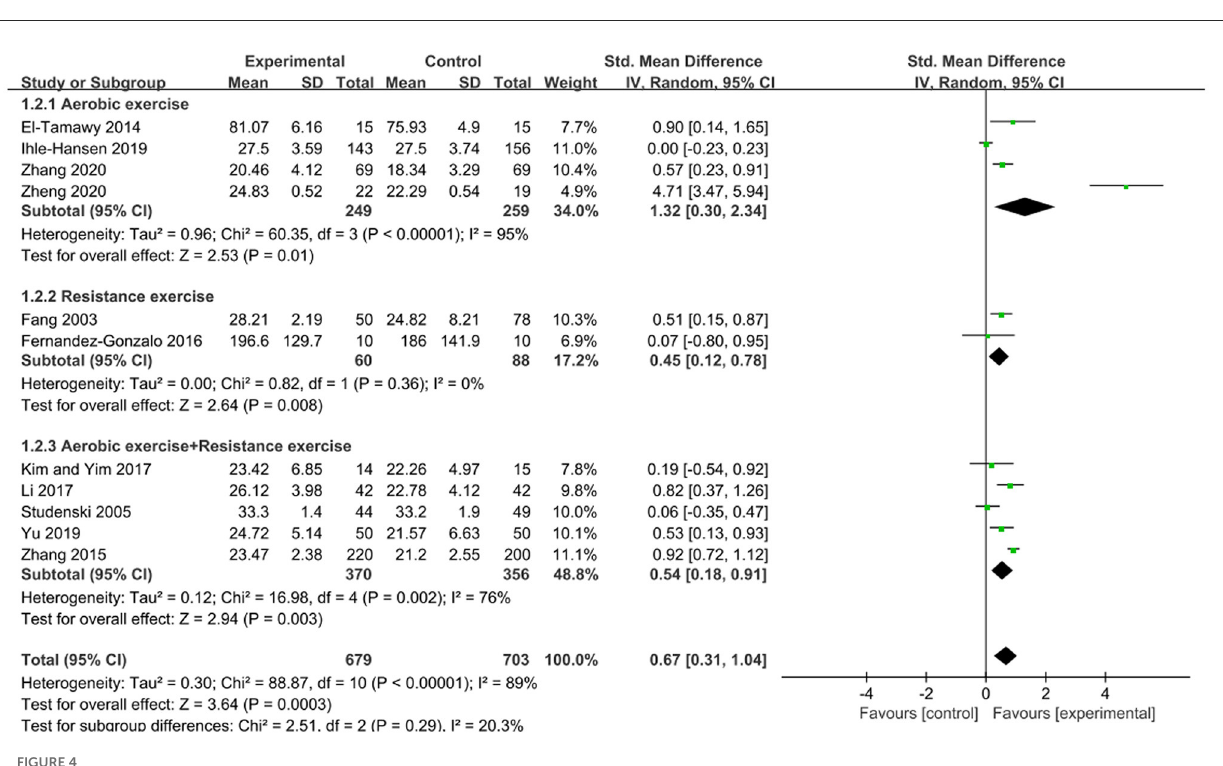
activities of daily living of the experimental group were higher than those of the control group after the intervention, and the difference was statistically significant [ MD = 8.11, 95% CI (3.07, 13.16), P = 0.002], as shown in Figure